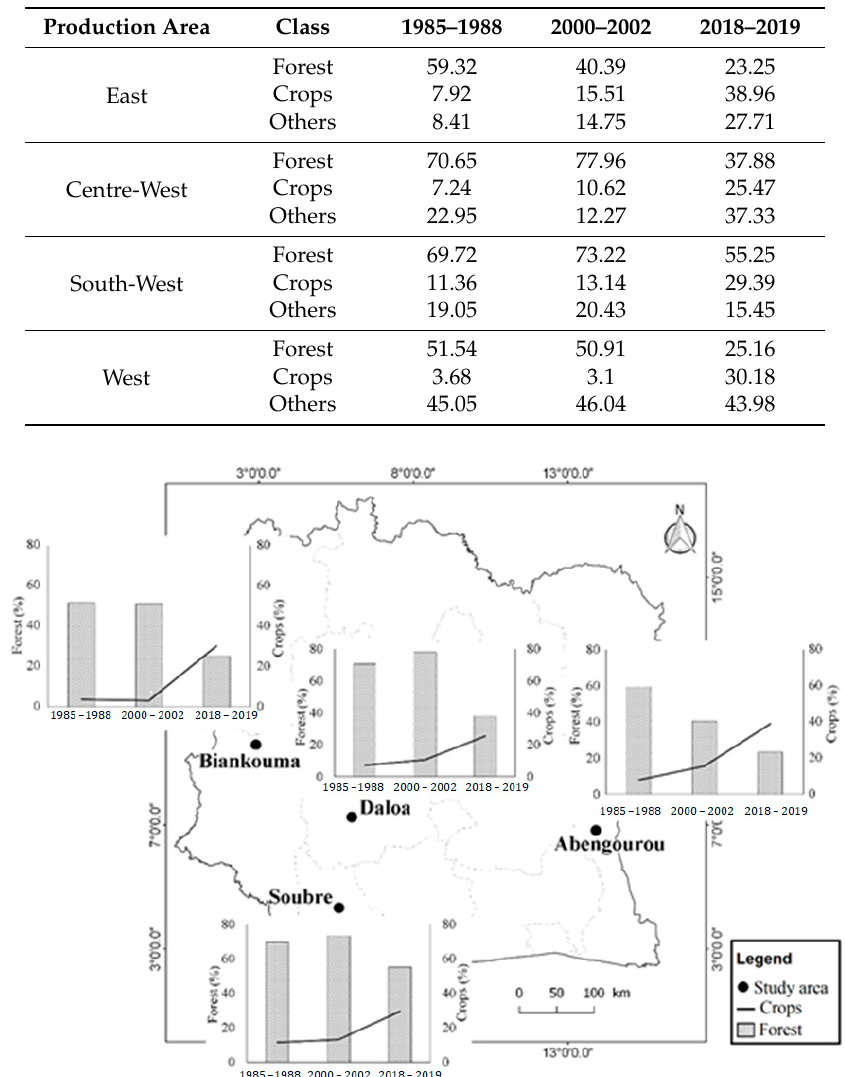
Figure 5. Changes in proportions of forest area and crops in the different cocoa production regions in Ivory Coast.